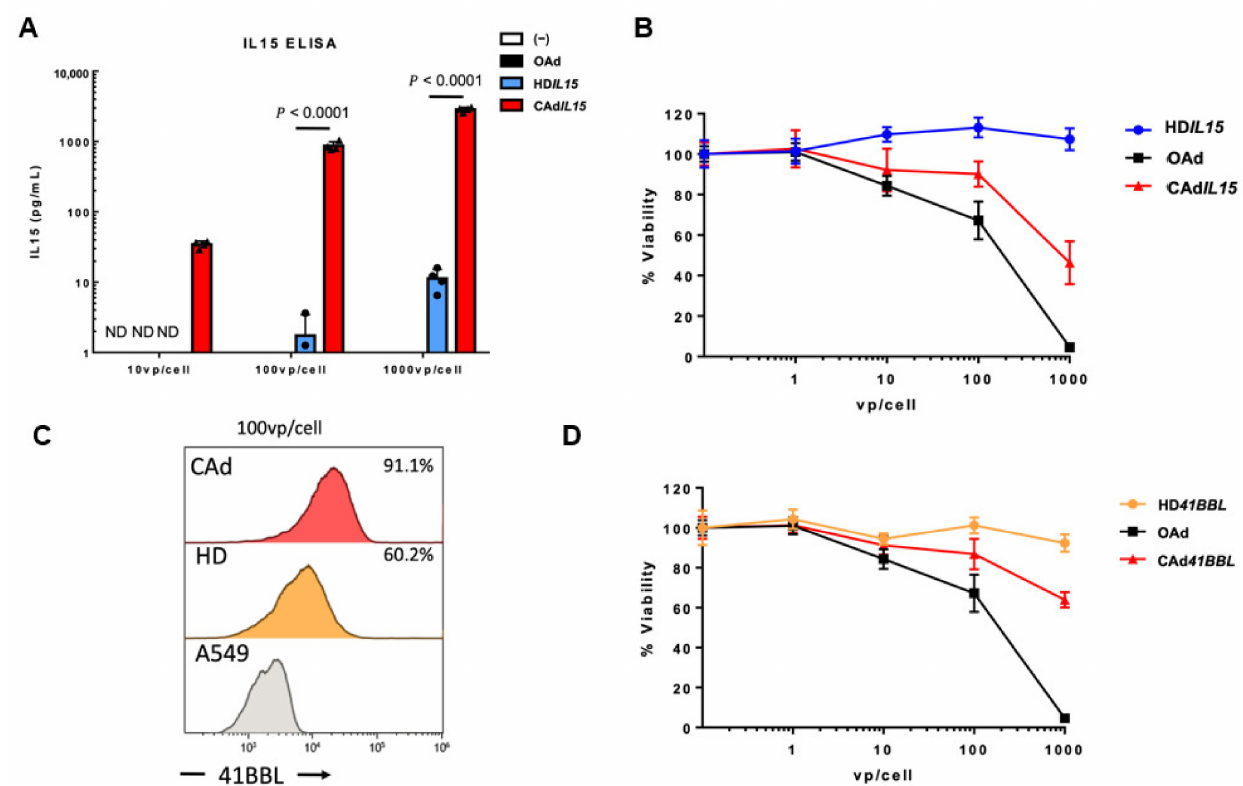
Figure 3. Co-infection with OAd amplifies HDAd encoded transgenes and maintains oncolysis. ( A ) A549 cells were infected with a total of 10 vp/cell, 100 vp/cell, or 1000 vp/cell of HD5/3 IL15 or CAd5/3 IL15 (OAd:HDAd, 1:1). Medium samples were collected 24 h post-infection. The levels of IL15 in medium samples were quantified by IL15 ELISA assay. Data are presented as means ± SD ( n = 4). ND = Not detectable. ( B ) A549 cells were infected with increasing doses of HD5/3 IL15 or OAd or with CAd5/3IL15 (OAd:HDAd, 1:1). Viable cells were analyzed at 96 h by MTS assay. Data are presented as means ± SD ( n = 6). ( C ) A549 cells were infected with a total of 100 vp/cell of HD5/3 41BBL or CAd5/3 41BBL (OAd:HDAd, 1:1). Cell surface expression of 41BBL expression was assessed by flow cytometry 48 h post-infection. ( D ) A549 cells were infected with increasing doses of HD5/3 41BBL or OAd5/3 or CAd5/3 41BBL (OAd:HDAd, 1:1). Viable cells were analyzed at 96hrs by MTS assay. Data are presented as means ± SD ( n =